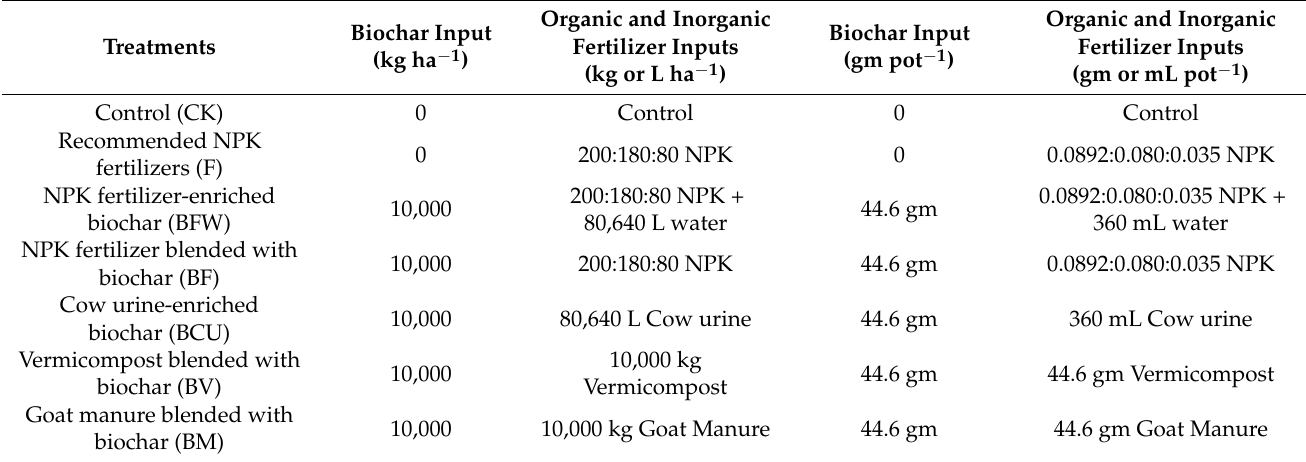
Table 2. Description of various biochar-based organic and inorganic fertilizer